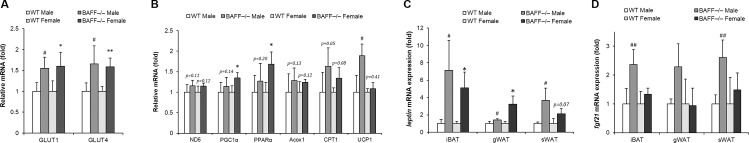
BAFF deficiency enhances expression of genes involved in glucose transport and thermogenic program in brown adipose tissue.(A) Effect of BAFF deficiency on glucose transporter gene expression in brown adipose tissue. (B) Effect of BAFF deficiency on expression of thermogenic and lipid oxidative genes in brown adipose tissue. (C and D) Effect of BAFF deficiency on leptin and FGF21 mRNA expression level in adipose tissues. Total RNA was isolated from brown, gonadal and inguinal adipose tissues of mice with HF feeding and mRNA expression level was analyzed. Gene expression level is normalized with mRNA expression level of Arbp (n = 4~5). *p < 0.05 and **p < 0.01 between female WT and female BAFF-/- mice. #p < 0.05 and ##p < 0.01 between male WT and male BAFF-/- mice. iBAT: interscapular brown adipose tissue, gWAT: gonadal white adipose tissue, sWAT: subcutaneous white adipose tissue.